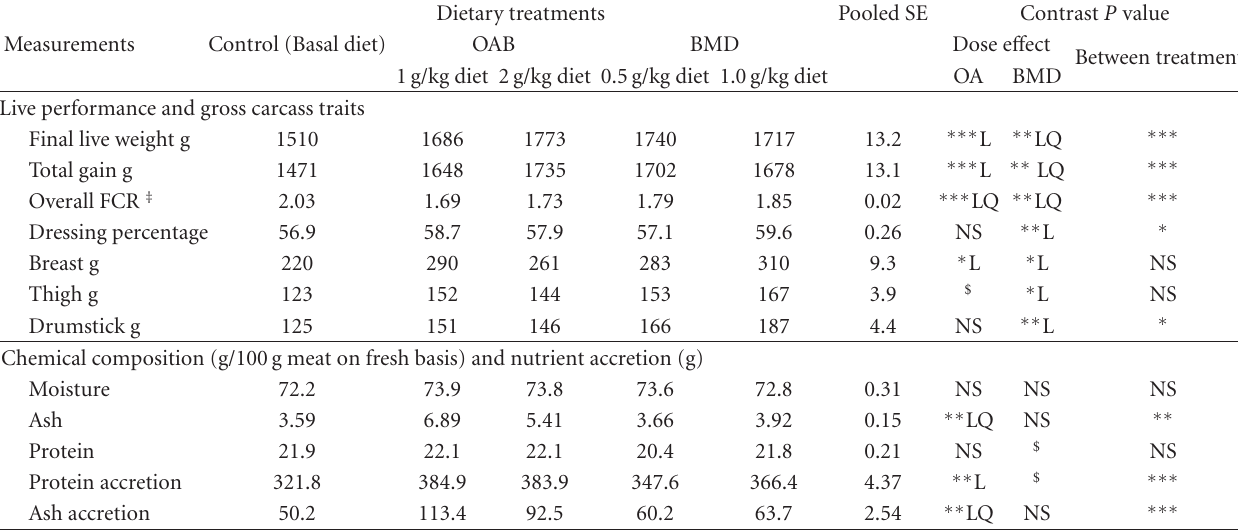
Table 3: E ff ects of feeding an organic acid blend (OAB) and bacitracin methylene disalicylate (BMD) at di ff erent dose levels on performance traits and carcass characteristics in broiler chicken †